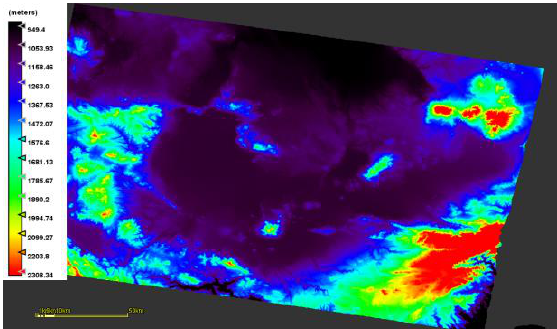
Figure 7. DEM Generated With Nearest Neighbour